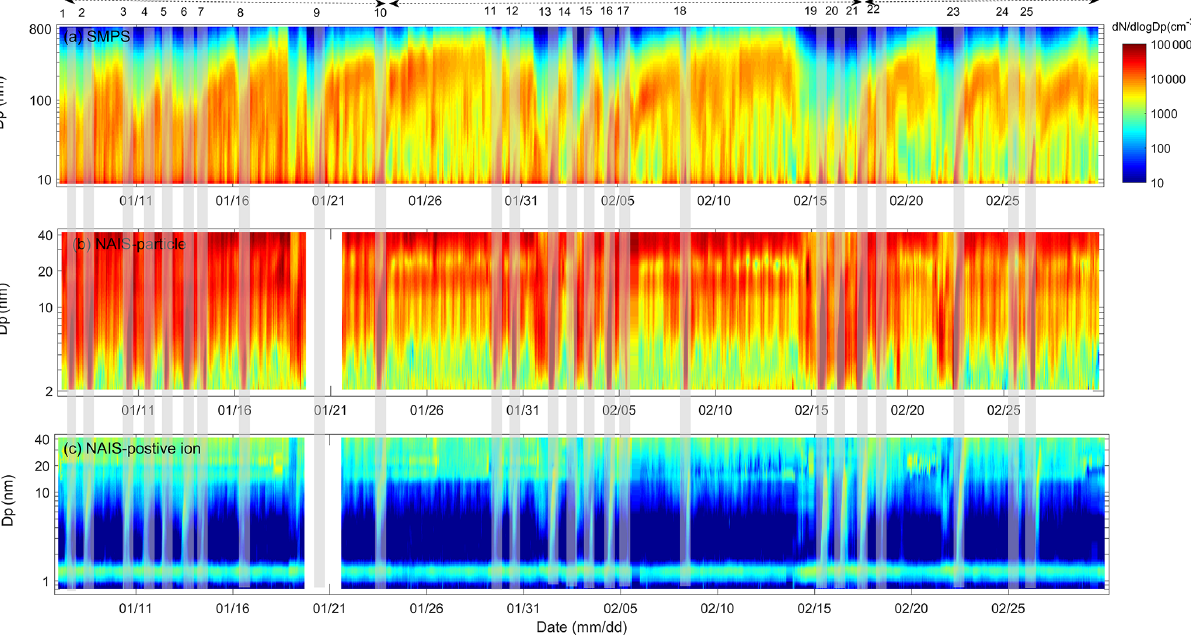
Figure 2. Time evolution of number size distribution of 10–850nm particles by SMPS (a) , neutral 2–42nm particles by NAIS in positive particle mode (b) , and positive 0.8–42nm ions by NAIS (c) . NPF events were marked by numbers from